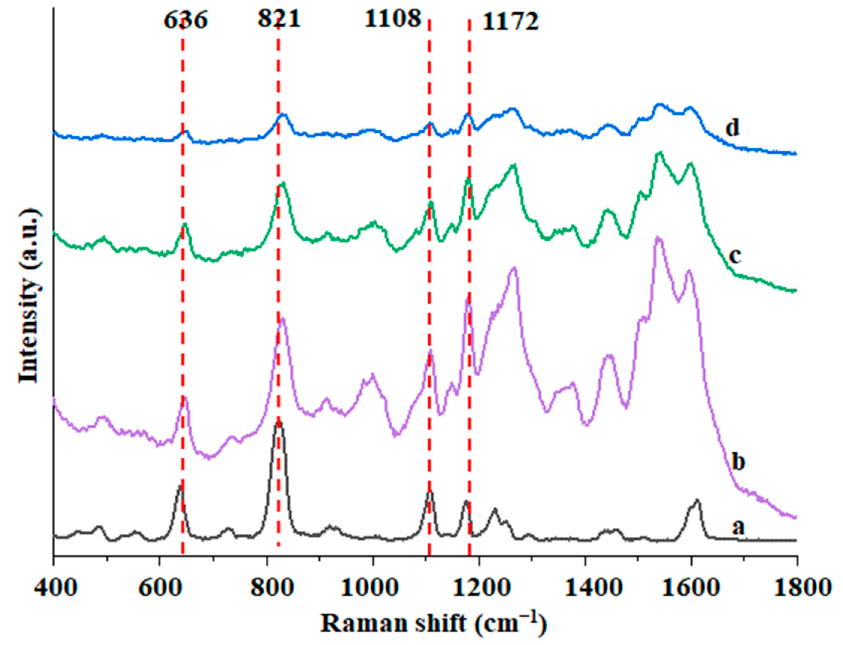
Figure 3. SERS spectra of BPA in Au@ZIF-8 nanoparticles in methanol solution ( a . solid BPA standard, b . 3 nmAu@ZIF-8, c . 20 nm Au@ZIF-8, and d . 50 nm Au@ZIF-8).